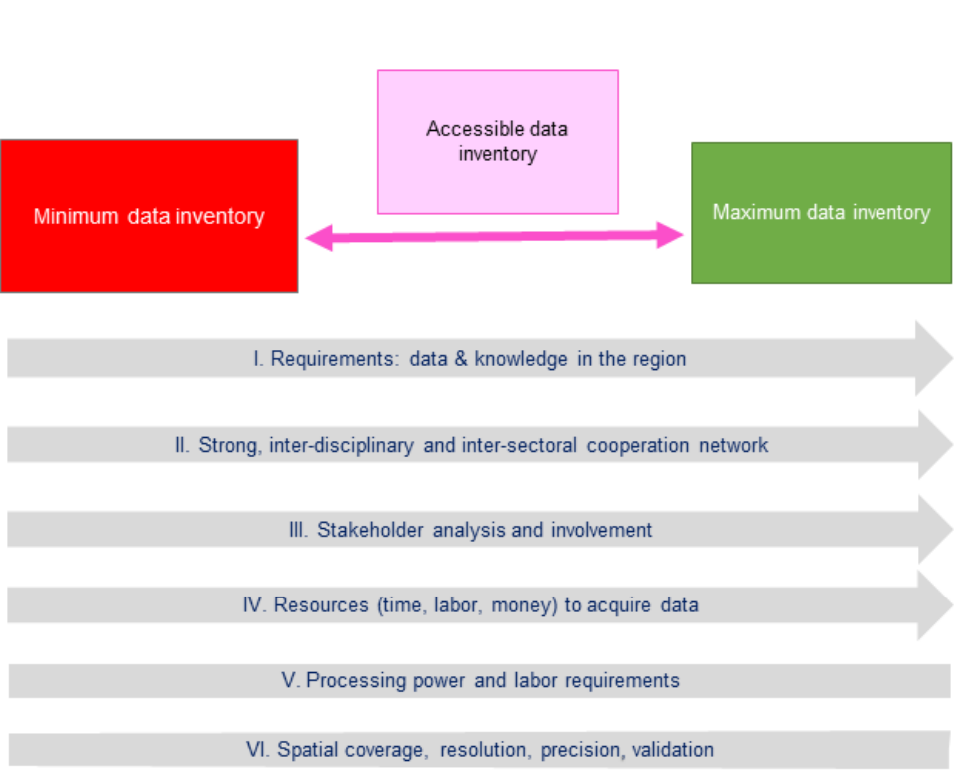
Figure 1. Stakeholders’ operating space for analysis of land and water resources in data scarce semi-arid regions. (An inventory is any dataset collected in a region of interest, along with administration and commercial institutions available for analysis supporting management decision. Three types of inventories can be defined based on data availability. The minimum data inventory is the minimum dataset needed to identify leverage areas for sediment management. These data are freely available (globally and regionally). The maximum data inventory contains all data needed for an analysis in